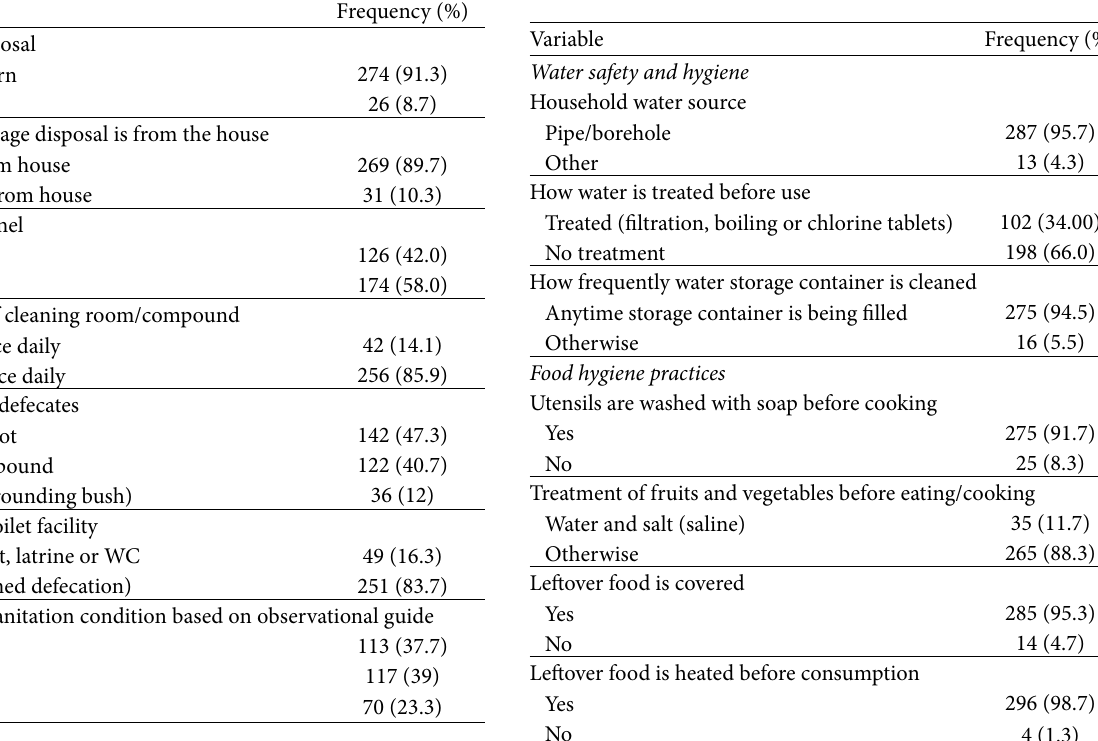
Table 2: Household hygiene and sanitation conditions. Table 3: Water and food hygiene practices in the households of the